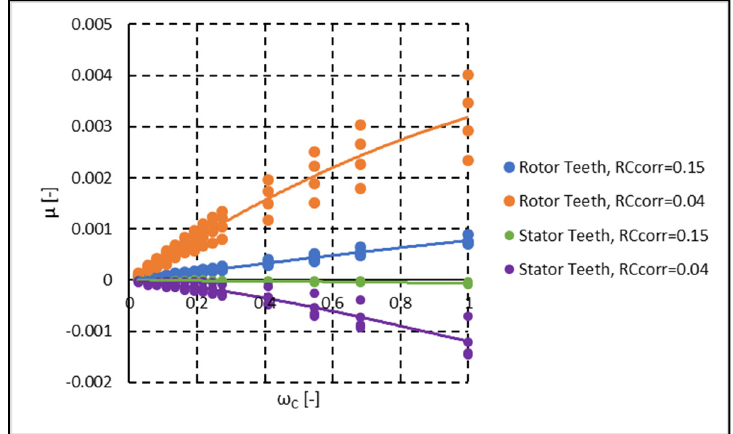
Figure 11. Total enthalpy trendlines.